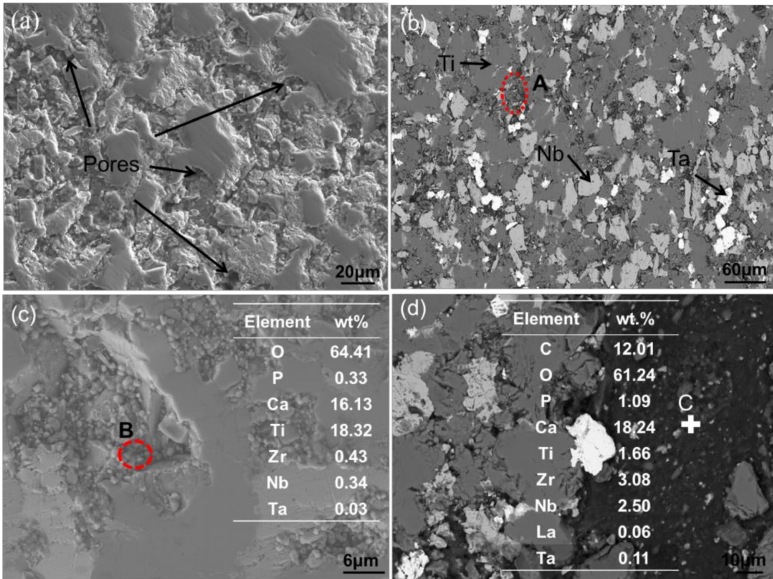
Figure 5. ( a , b ) SEM micrographs of the 0.5-GNFs nanocomposite in different regions; and ( c , d )